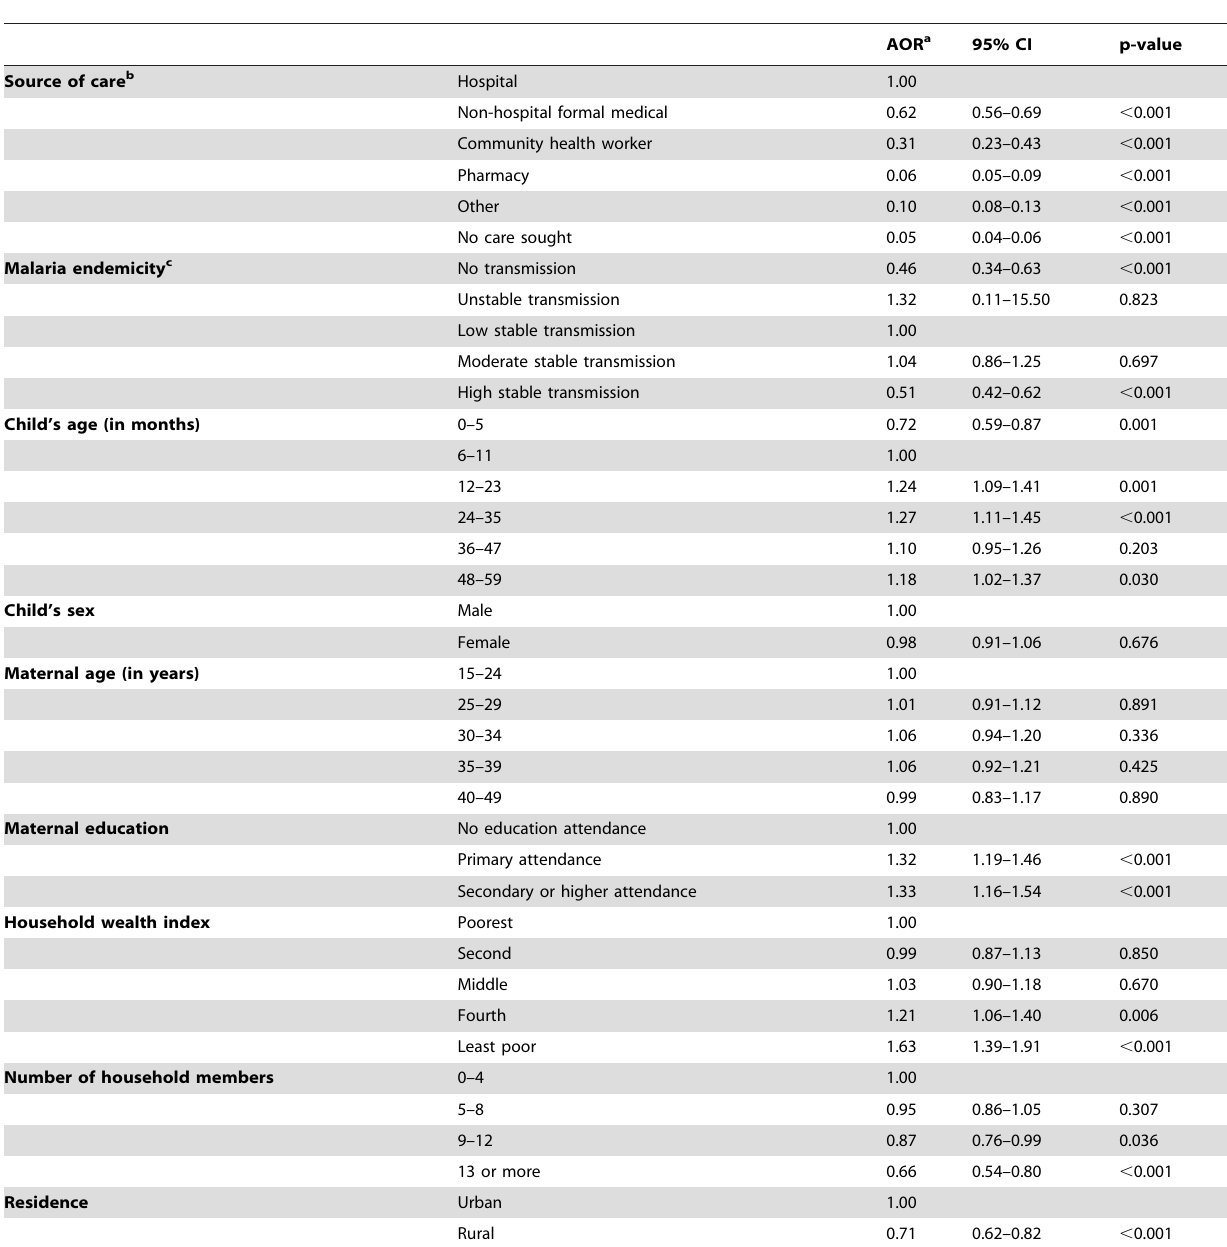
Table 3. Effect of source of care, malaria endemicity and socioeconomic covariates on test